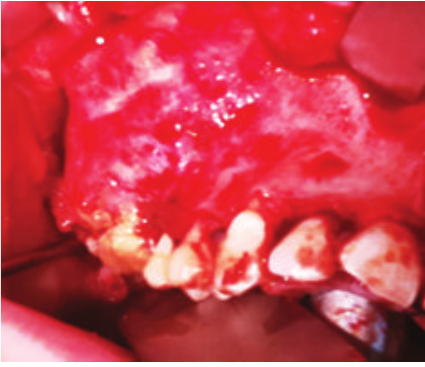
Figure 2: Orthopantomogram. Figure 3: Intraoperative photo of